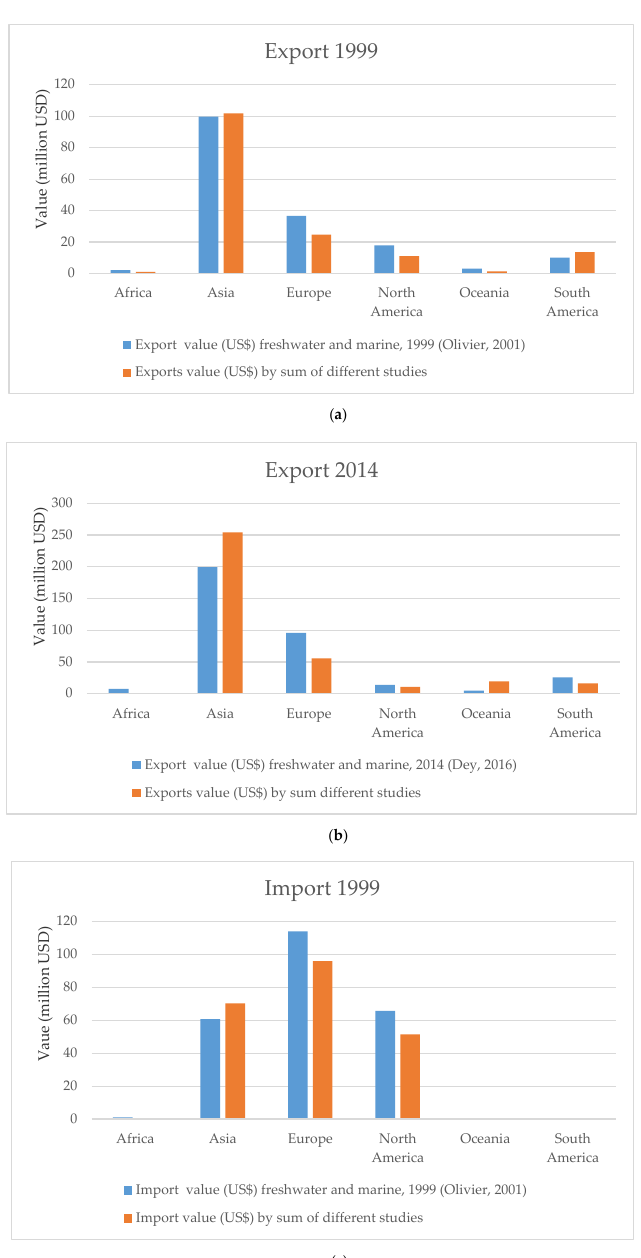
Figure 5. ( a ) Wholesale value in million USD of exports of freshwater and marine fishes by region in 1999 [17] compared with the sum of country exports for the same or closest year for which data were available. ( b ) Wholesale value in million USD of exports of freshwater and marine fishes by region in 2014 [16] compared with the sum of country exports for the same or closest year for which data were available. ( c ) Wholesale value in million USD of imports of freshwater and marine fishes by region in 1999 [17] compared with the sum of country exports for the same or closest year for which data were available